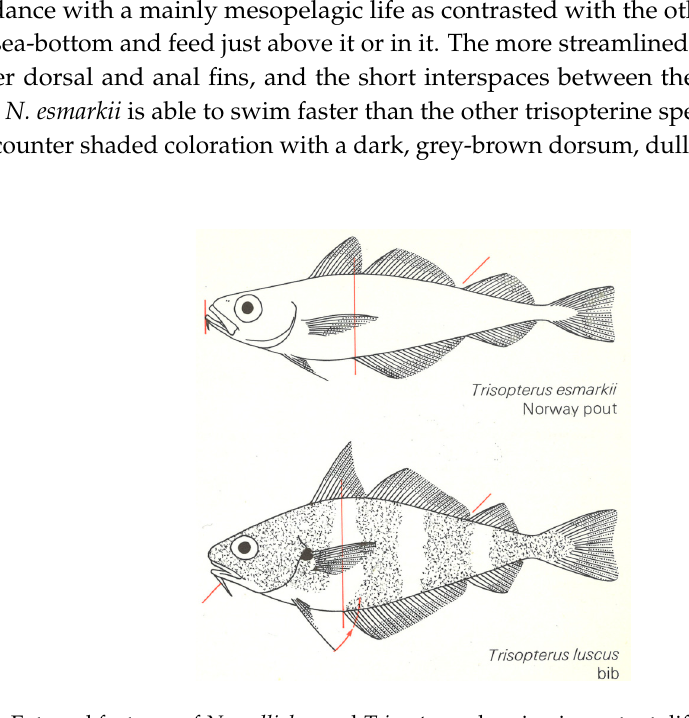
Figure 3. External features of Neocolliolus and Trisopterus showing important differences indicated with red lines. From Wheeler (1978) [45]. Table 4. Distinguishing external and ecological characteristics of Neocolliolus esmarkii with regard to the other recent trisopterine species.